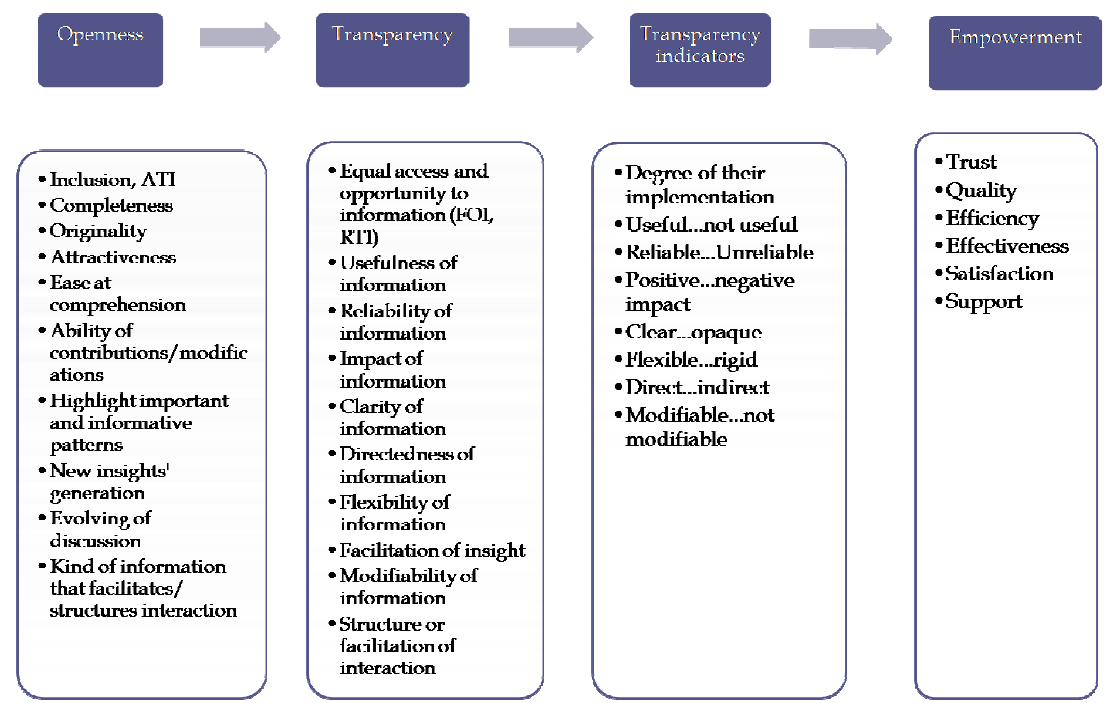
Figure 1. Interrelations between openness, transparency and